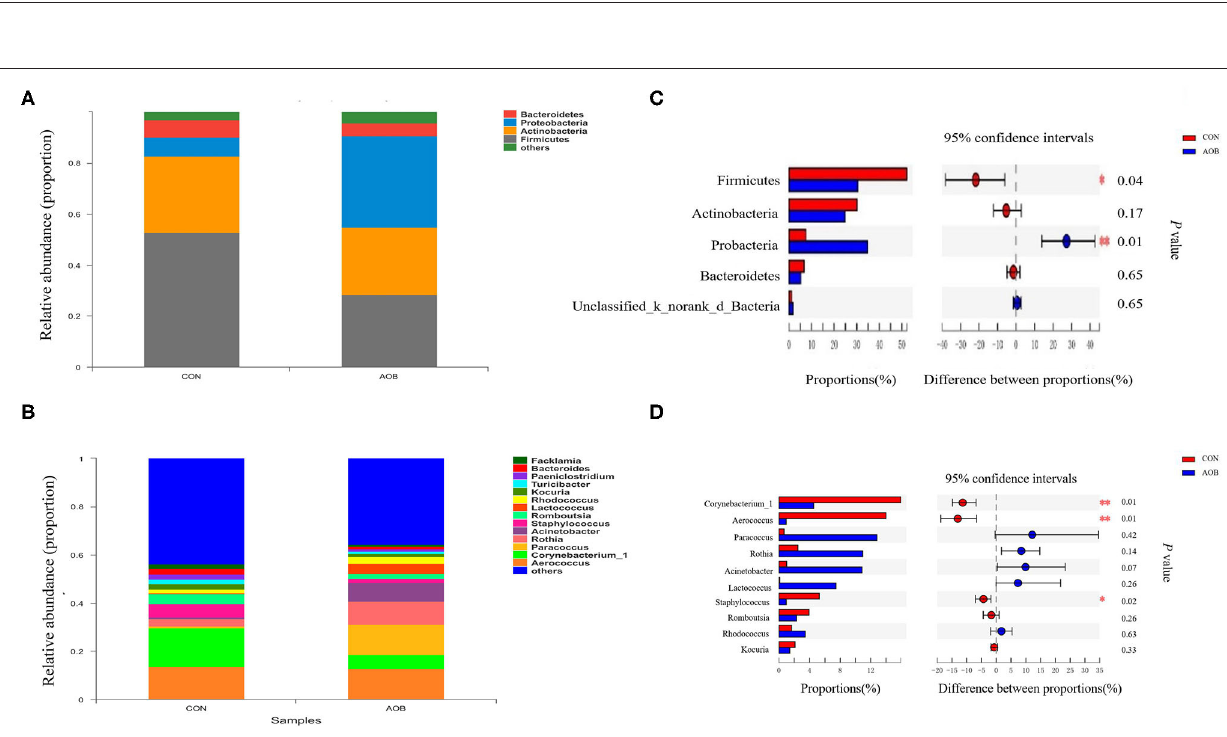
Frontiers in Nutrition |